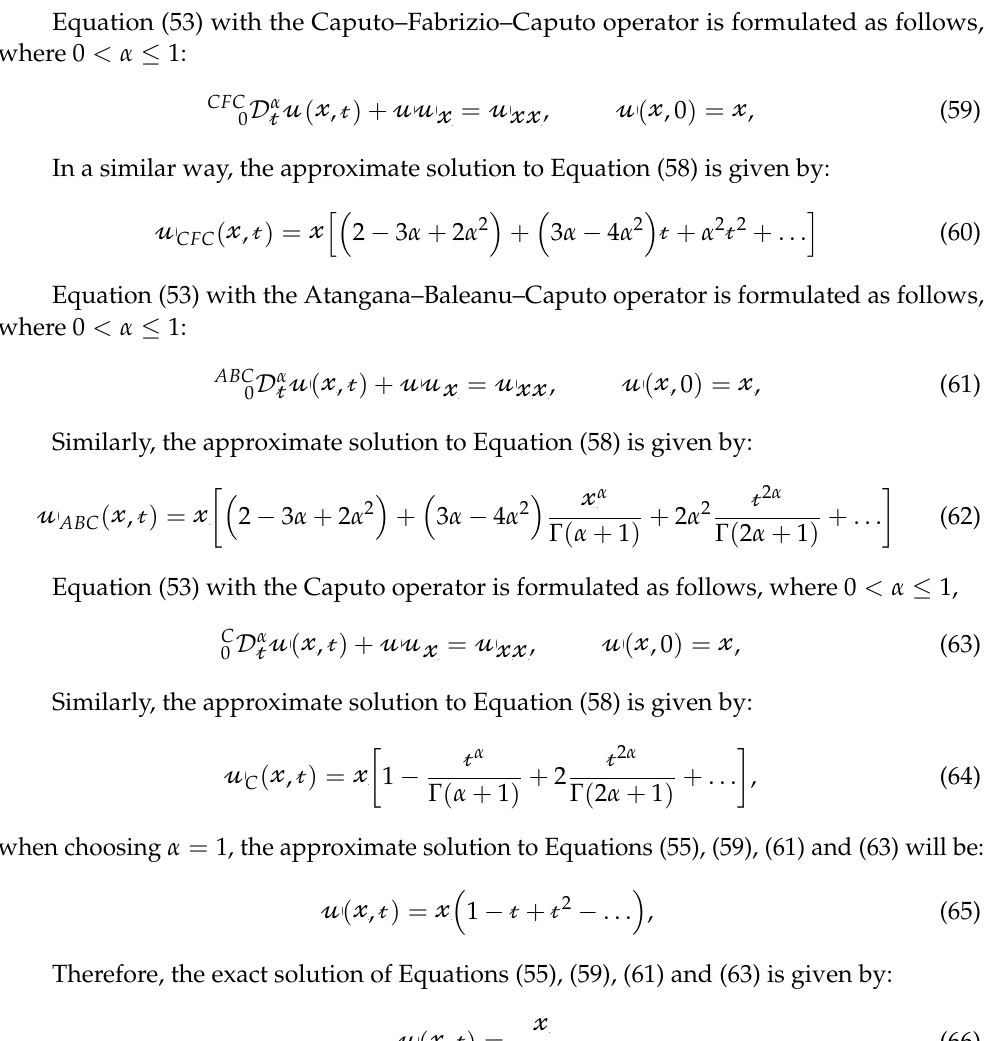
Table 2. The values of the approximate and exact solutions at 𝛼 = 1 and absolute error of Equa- tions (55), (59), (62), (64) and (66) at different values of 𝓉, 𝓍 .